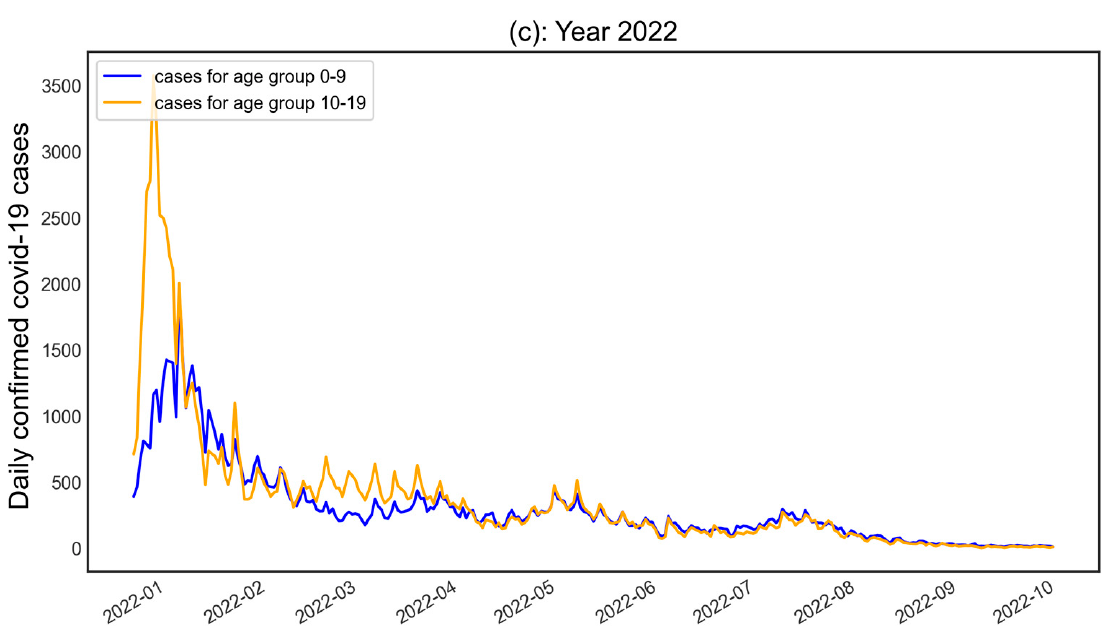
Figure 5. Daily confirmed COVID-19 cases for age groups 0–9 and 10–19 in ( a ) 2020, ( b ) 2021, and ( c ) 2022. The blue line shows the daily cases for the 0–9 age group, while the orange line shows the daily cases for the 10–19 age group.